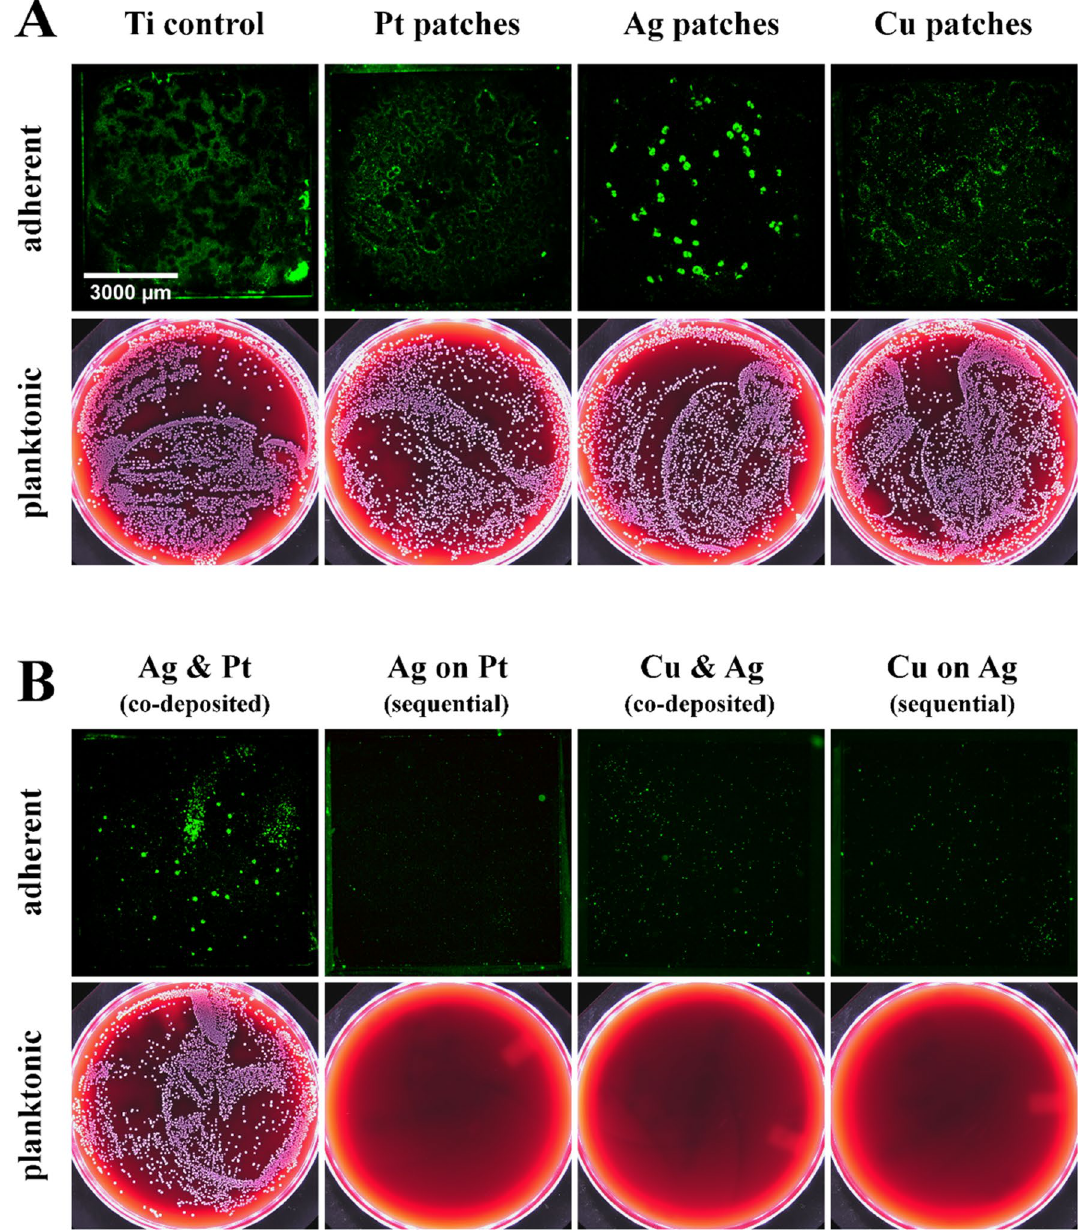
Figure 3. Antibacterial activity towards S. aureus (10 4 CFU/mL) of ( A ) a continuous Ti thin film (Ti control) as well as Pt, Ag, and Cu thin nanopatches sputtered on Ti thin film compared to ( B ) thin Ag/Pt and thin Ag/Cu nanopatches sputtered simultaneously (i.e., co-deposited) or sequentially (first Pt, second Ag or first Ag, second Cu). Sputter time for all samples 60 s. Upper figures: representative fluorescence images of adherent bacteria on sample surfaces after 24 h of incubation and staining with SYTO-9 (green fluorescence); lower images: representative blood agar plates of plated planktonic bacteria in the drop fluid after 24 h of incubation on the different samples (white bacterial colonies indicate viable